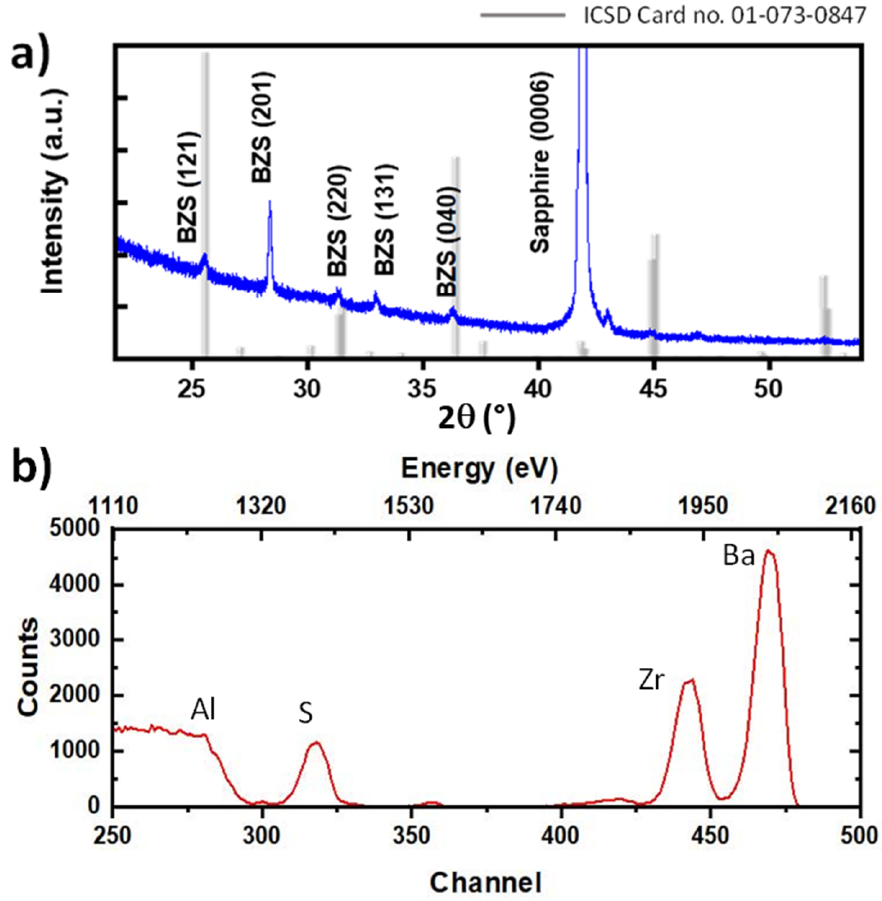
Figure 2. ( a ) XRD θ − 2θ scan of the as prepared single phase BZS thin film synthesized by a polymer-assisted deposition, where the experimental data are shown in blue, and the peak positions from PDF card ICDD 01-073-0847 are shown as stick patterns in gray. The high intensity peak corresponds to the (0006) c -plane sapphire substrate. ( b ) RBS spectra (2.3 MeV 4 He + ) of the as prepared BZS film. The film thickness was estimated to be 83 nm. The atomic ratio of Ba:Zr:S was found to be 1.00:1.03:3.02 by fitting the RBS spectra. Small amount of other elements such as Ar (355 channel) and potentially Zn or Cu (418 channel) from the RBS spectrum may come from the contamination during the process. The atomic ratios are within 5% errors based on RBS